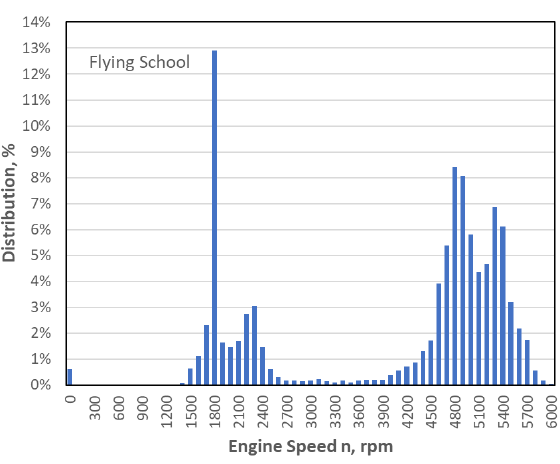
Fig. 6. Distribution of engine speed during training flights